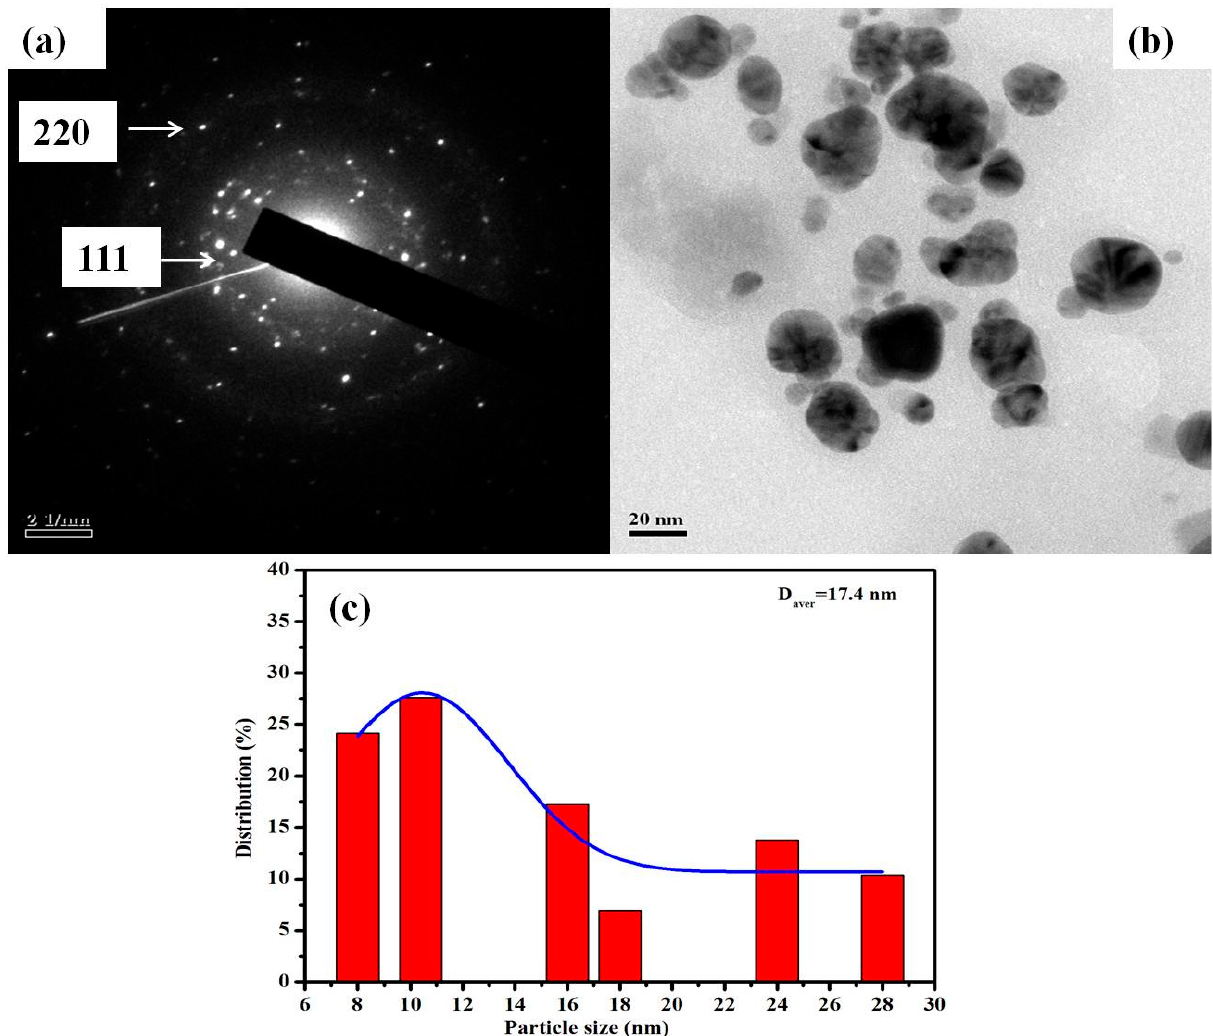
Figure 3. TEM micrograph of the synthesized AgNPs. ( a ) SAED pattern of synthesized AgNPs. ( b ) Analysis of the morphology of AgNPs. ( c ) Histogram showing the size distribution of AgNPs.